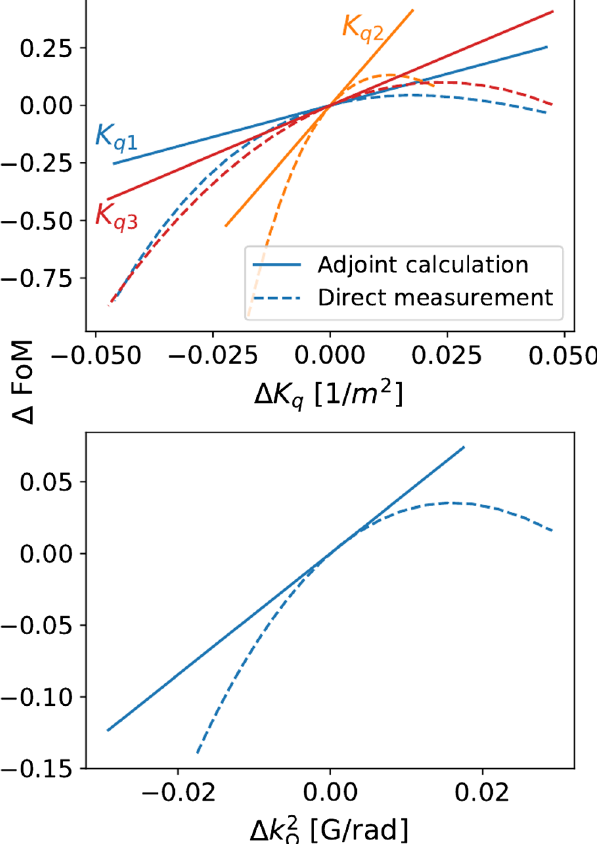
FIG. 3. Comparison of changes in a figure of merit calculated using the adjoint method (straight lines) and calculated directly (curved